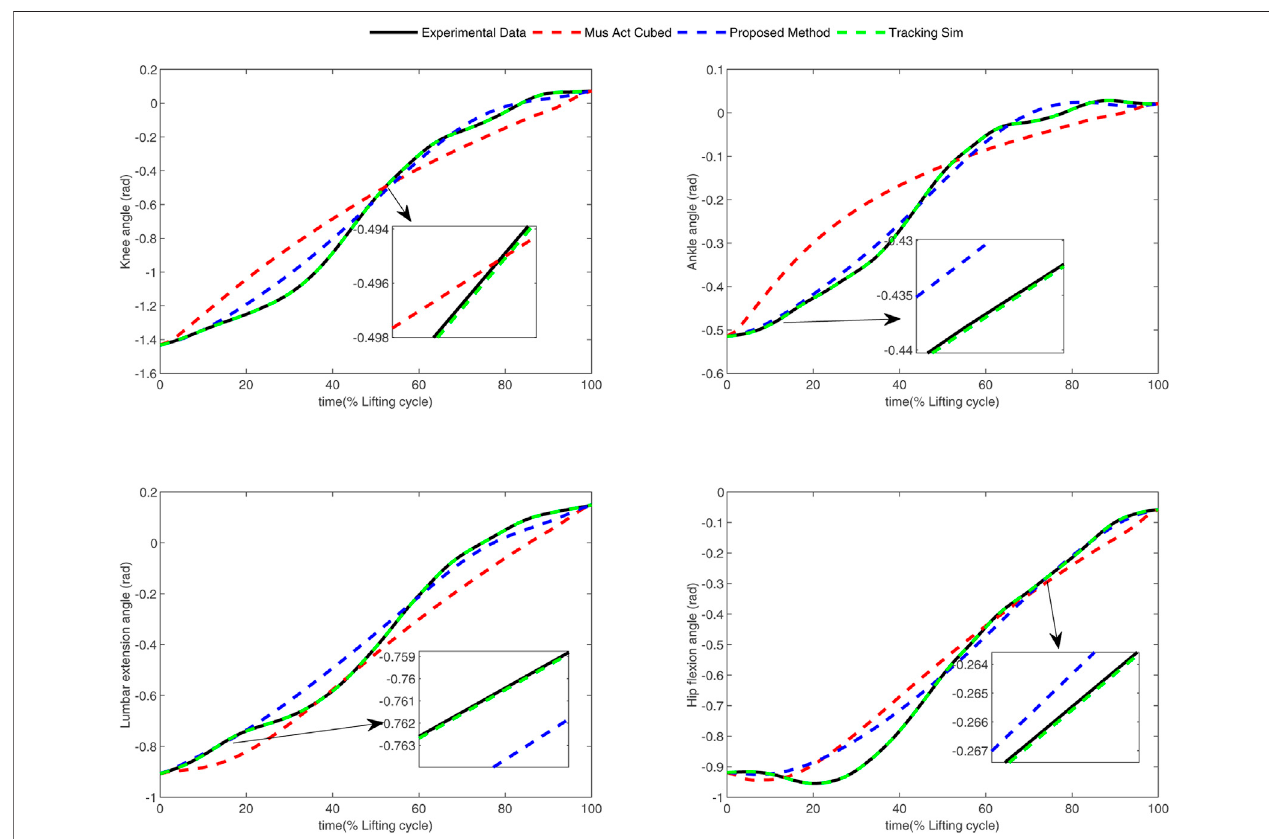
FIGURE 8 | Kinematics results of different joints obtained by different methods for subject